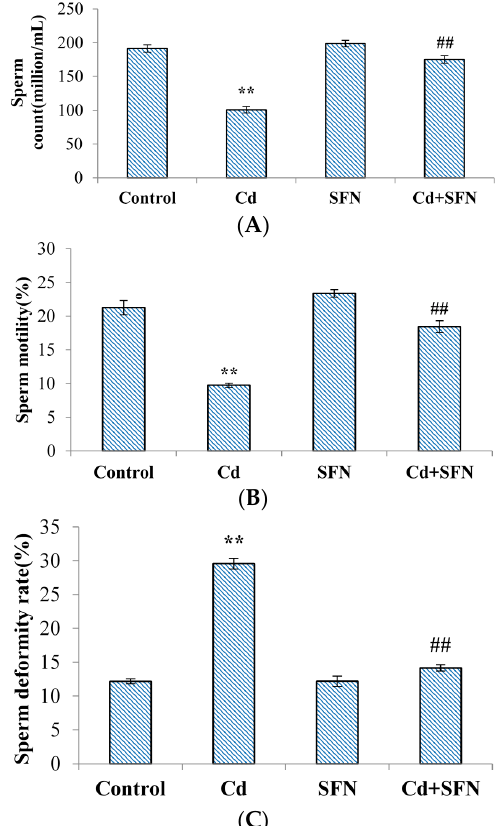
Figure 1. Effect of SFN on sperm quality in mice. ( A – C ) After the mice were killed, sperm count ( A ); sperm motility ( B ); sperm deformity ( C ) were examined. Values represent mean ± SEM in each group of 10 mice. * and # denote significant differences; ** p < 0.01 vs. control group; ## p < 0.01 vs. cadmium group.